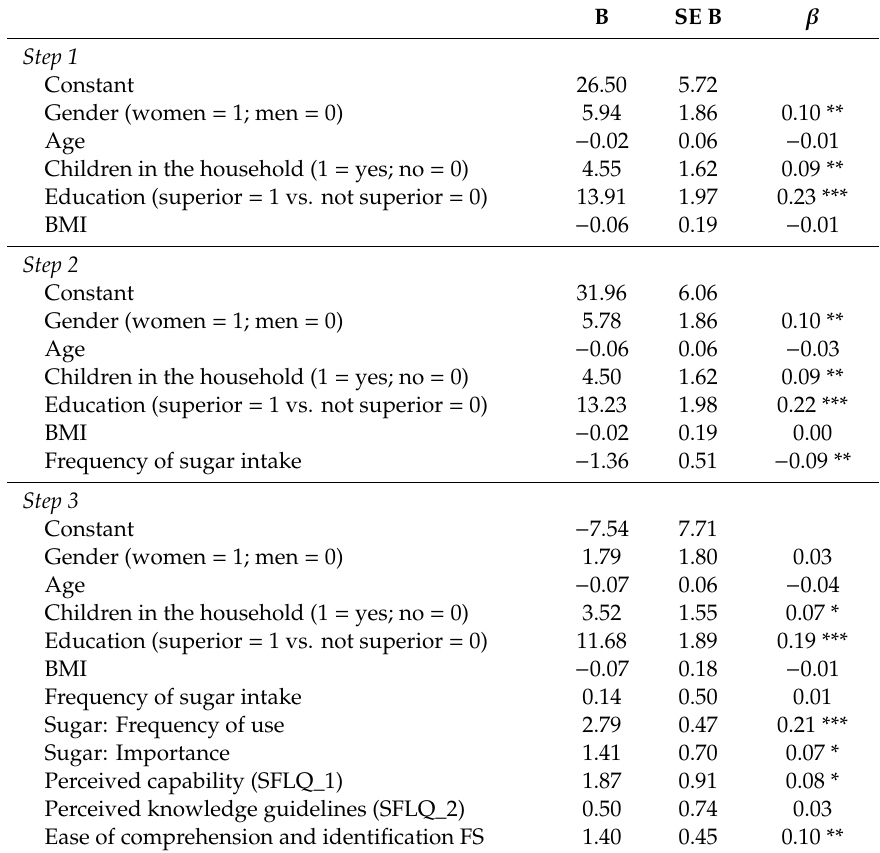
Table 3. Hierarchical regression analysis: accuracy in the sugar categorization